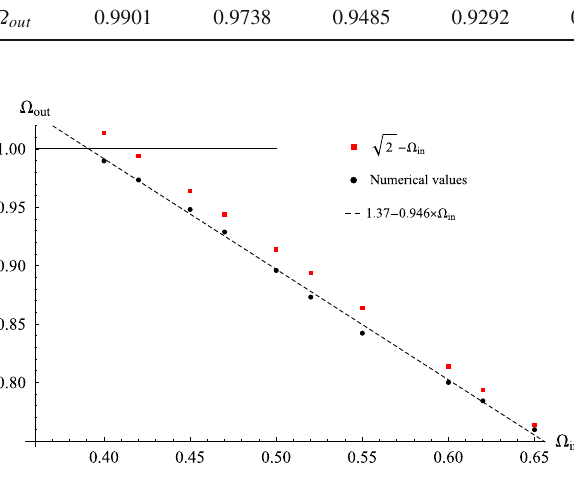
Fig. 9 The frequencies of the initial Q-balls Ω in = ω in quencies of the resulting Q-balls Ω out = ω out for the fit of the numerical data